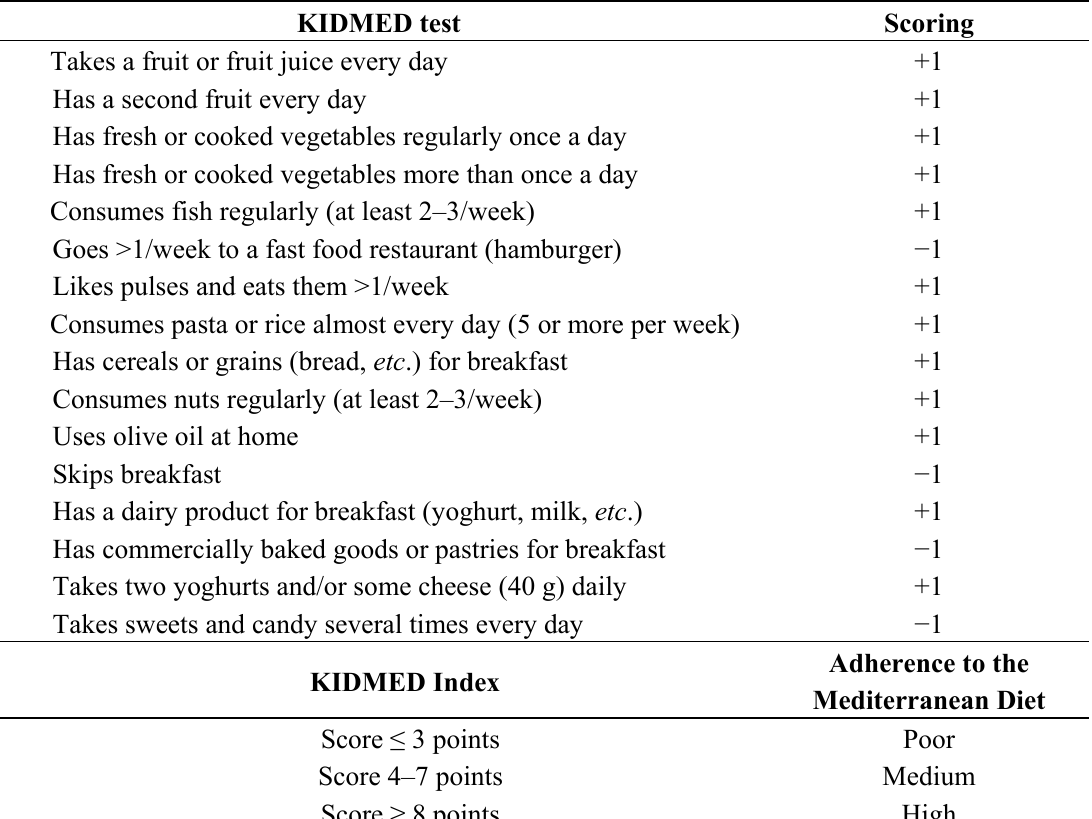
Table 2. KIDMED test to assess the Mediterranean Diet adherence [41]